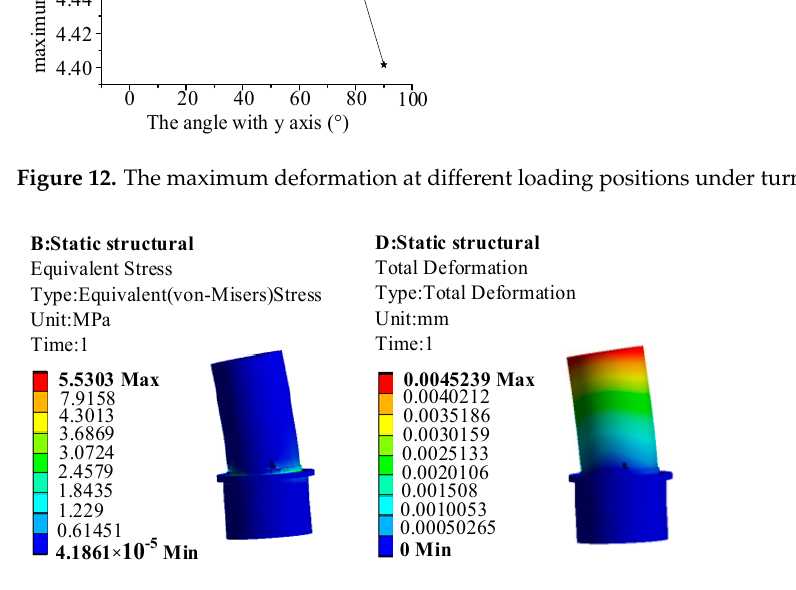
Figure 13. The turning stress nephogram and deformation nephogram of the maximum deformation position.